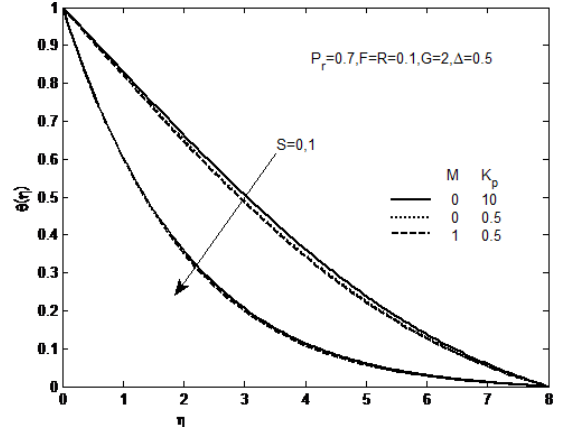
Fig. 9: Temperature profile for various values of S , M and K